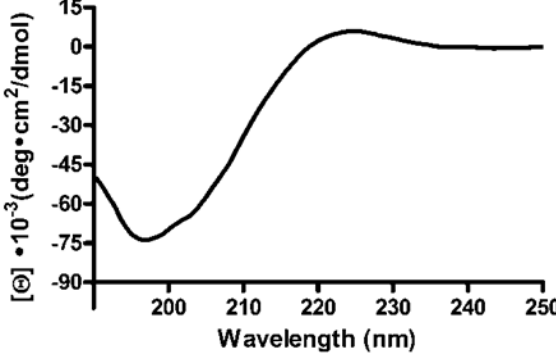
-THP determined by monitoring molar 6